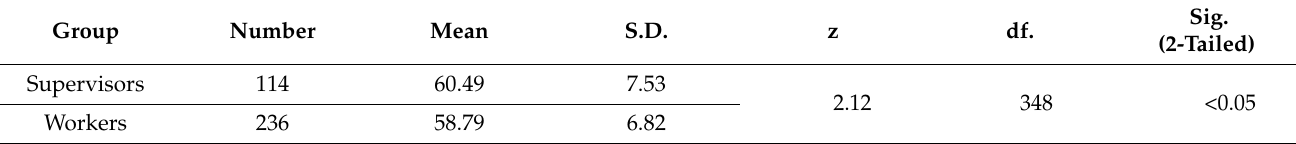
Table 6. Mean difference in job satisfaction according to level of employees of the respondents (N = 350).